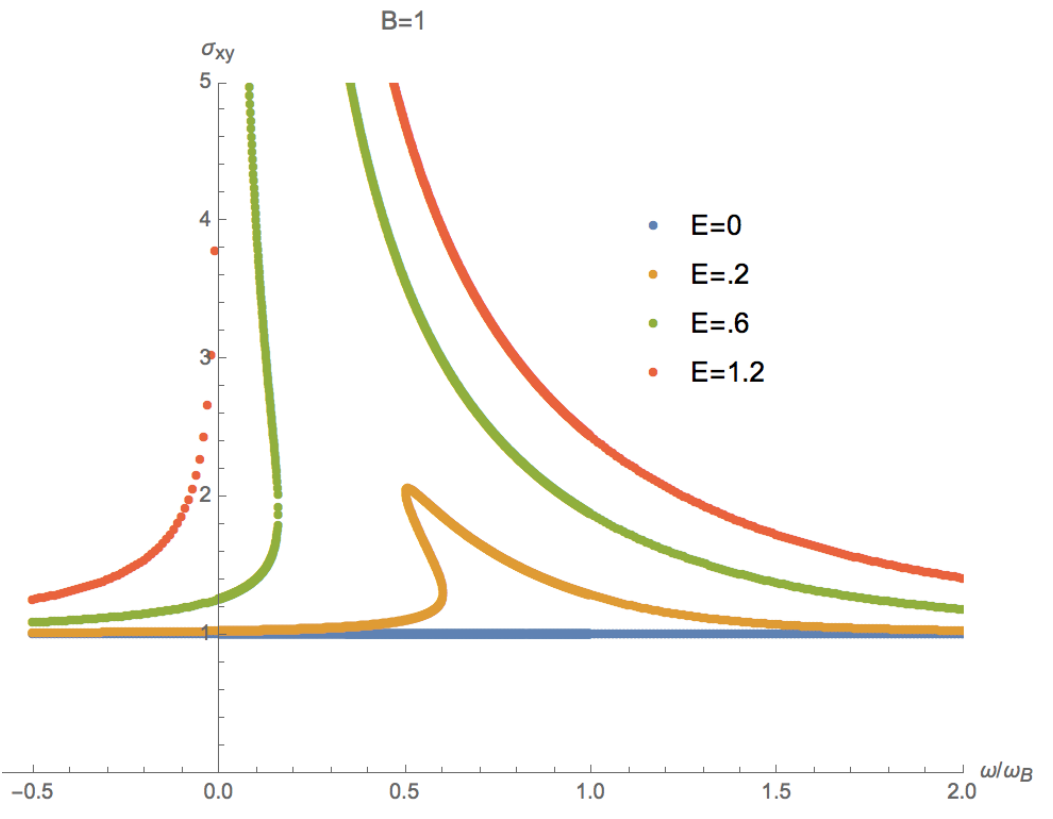
Figure 4 . Hall conductivities for various values of E with B = 1, (cid:27) Q = 0 : 25, (cid:26) = 1 and (cid:15) = 1. Each curve asymptotes to (cid:26)=B